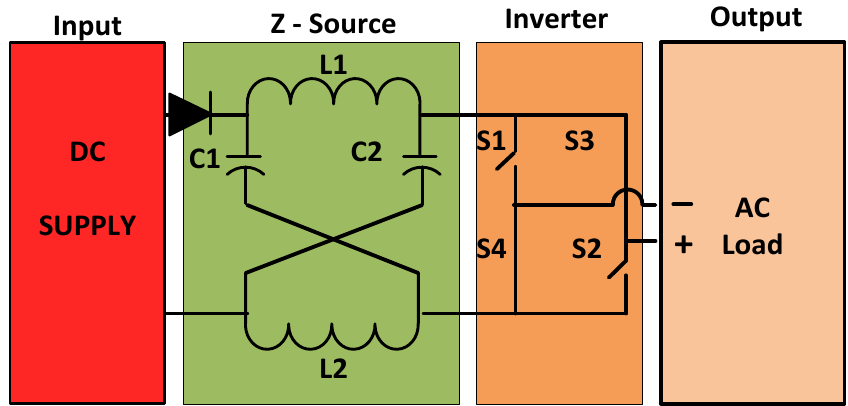
Figure 6. Z-Source DAD converter,inverter mode (positive half cycle). Figure 7. Z-Source DAD converter,inverter mode (negative half cycle). Figure 7. Z-Source DAD converter, inverter mode (negative half cycle).